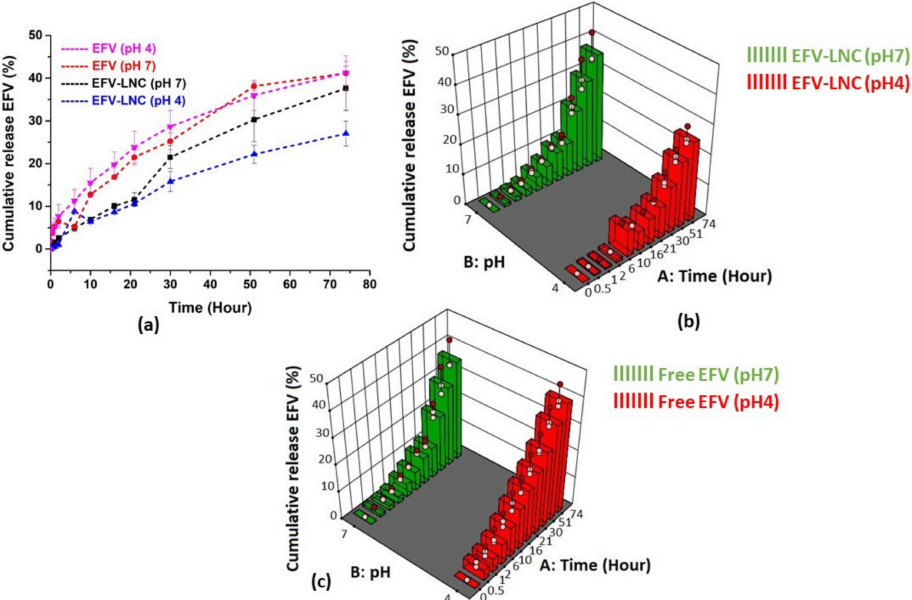
Figure 12. Interactive plot ( a ) and 3D surface plots of EFV-LNC ( b ) and free EFV ( c ) in vitro release profiles in both pH 7 and pH 4.